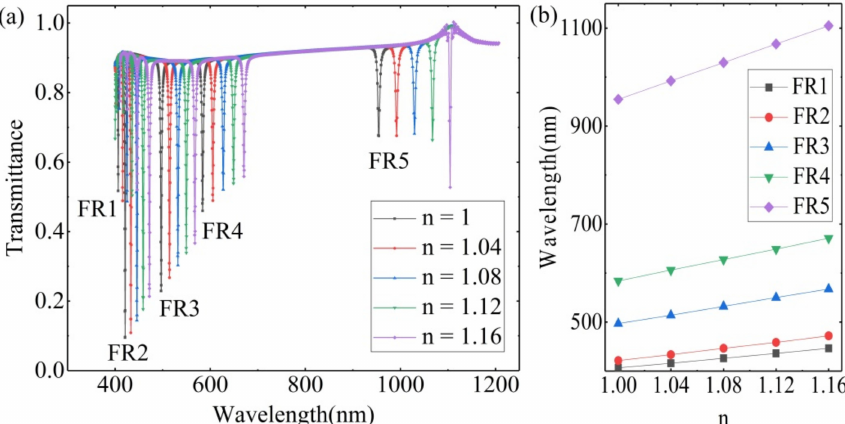
Figure 10. ( a ) The transmittance spectra of the designed structure with n varying from 1 to 1.16; ( b ) the resonance wavelength of FR1, FR2, FR3, FR4 and FR5 with different n.